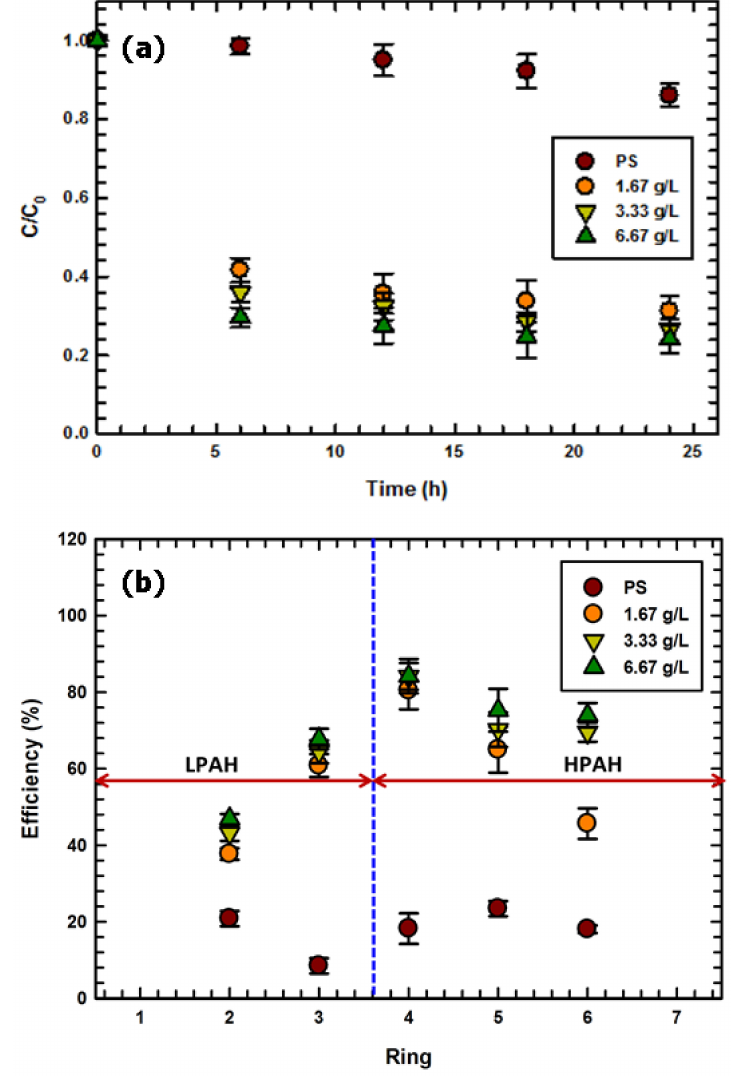
Figure 5. ( a ) Effect of Fe 3 O 4 –WB catalyst dosage and ( b ) efficiency of PAH degradation as function of ring number for various Fe 3 O 4 –WB catalyst dosages. Experimental conditions: amount of sediment = 1.00 g, reaction volume = 40 mL, T = 303 K, pH 0 = 6.0, [Na 2 S 2 O 8 ] = 2 × 10 − 5 M, and molar ratio of PS: ∑ PAHs =